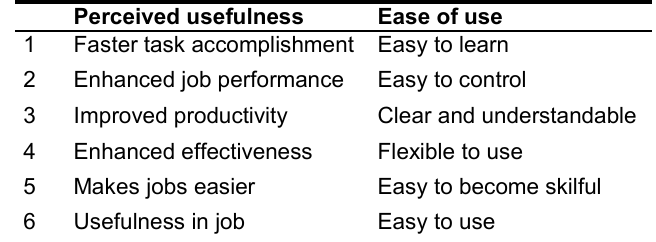
Table 1. Topics covered by the TAM-based questionnaire for RCSA